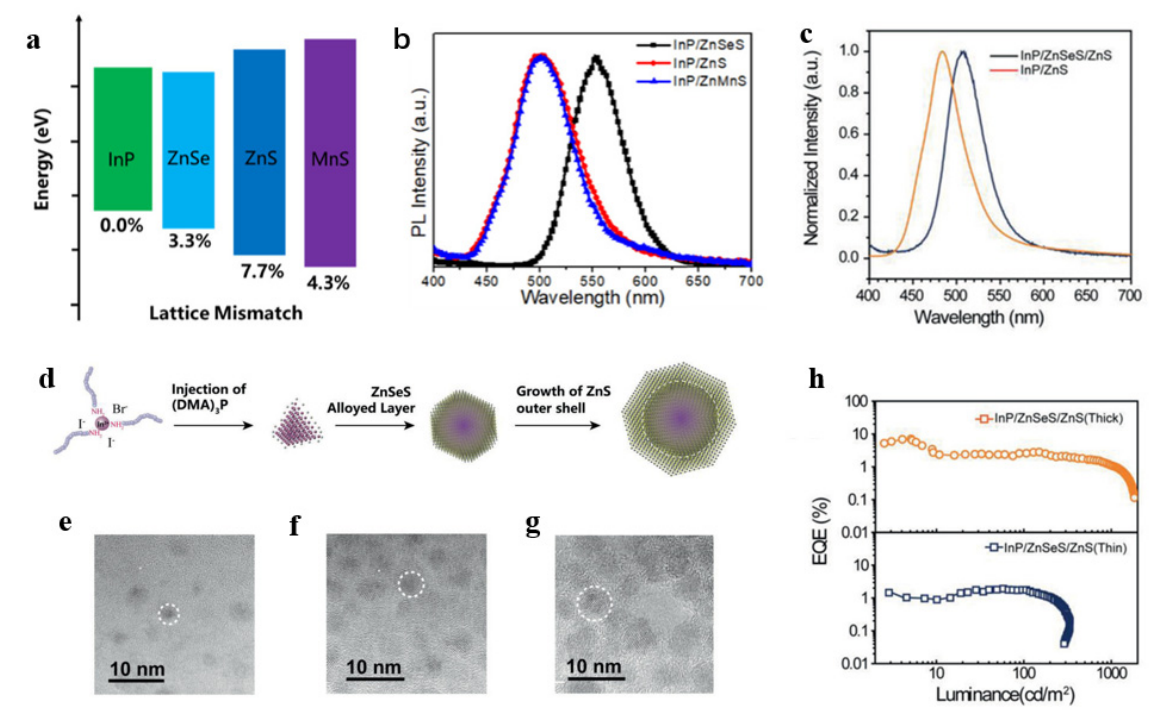
Figure 7. ( a ) Band gap and lattice mismatch of InP, ZnSe, ZnS, and MnS in the prepared green InP QDs. ( b ) PL spectra of InP QDs with different shells. Reprinted with permission from Ref. [83]. © 2019, American Chemical Society. ( c ) PL spectra of InP QDs synthesized with and without ZnSe content. ( d ) The growth stages of green InP QDs synthesized with (DMA)3P. ( e – g ) Aliquot study of three growth stages during reactions: InP cores, InP/ZnSeS QDs, and InP/ZnSeS/ZnS QDs. ( h ) EQE versus luminance of the two QLEDs. Reprinted with permission from Ref. [47]. © 2021, Wiley-VCH GmbH.